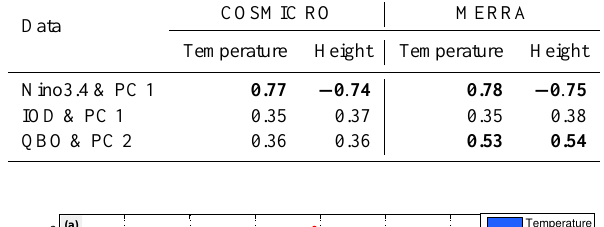
Table 4. Correlation coefficients between tropopause parameters (temperature and height) derived from COSMIC RO and MERRA and ocean–atmospheric indices for the period August 2006 to De- cember 2013. The values that are significant at 95% confidence level based on the reduced degree of freedom are bolded.